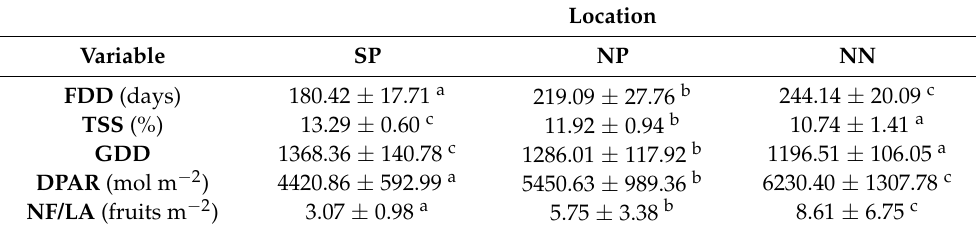
Table 1. Average value of plant parameters and DPAR during the fruit development period, from the anthesis until harvest: FDD (fruit development days); TSS (total soluble solids); GDD (growing degree days); DPAR (daily photosynthetically active radiation integral); NF/LA ratio (number of fruits per leaf square meter) in papaya orchards in different locations and environment modification structures (SP: south and plastic cover, NP: north and plastic cover, and NN: north and 40 mesh net